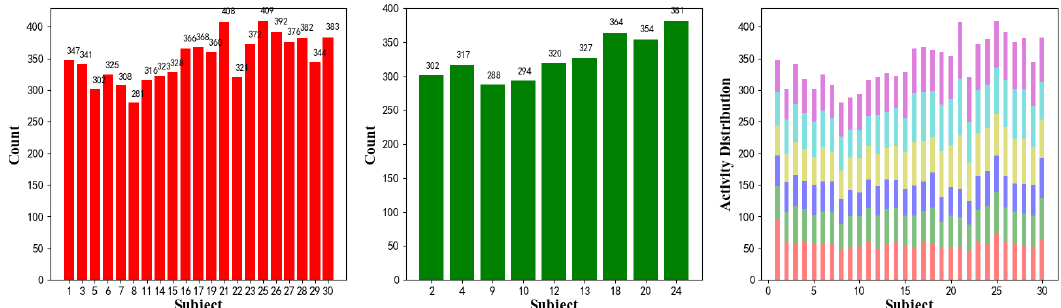
Figure 6. Human activity recognition dataset of UCI. Left : activity distributions of training data and related subjects; Middle : dataset distribution of validation data; Right : six activities’ distribution of 30 subjects.